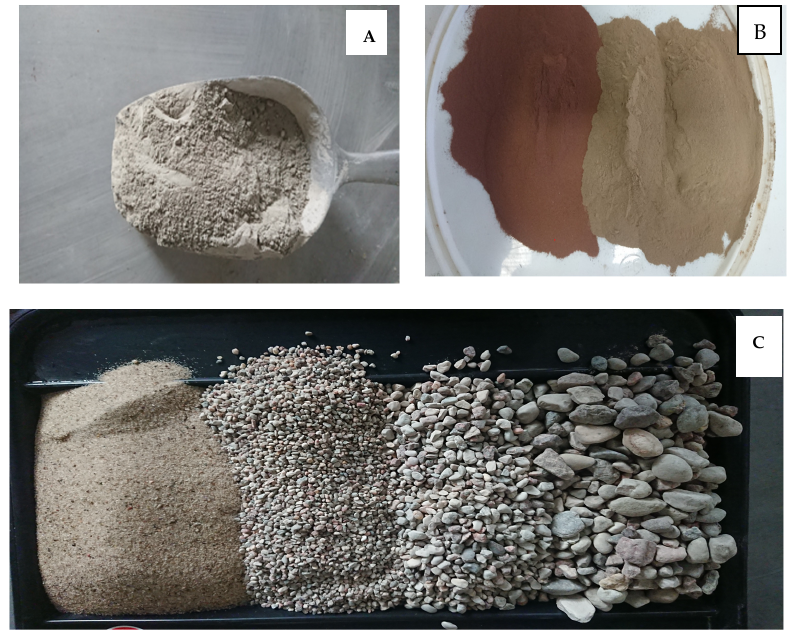
Figure 2. Concrete mixers: cement, settlement ash, leachate: ( A ) cement; ( B ) natural slag; ( C ) aggregate.